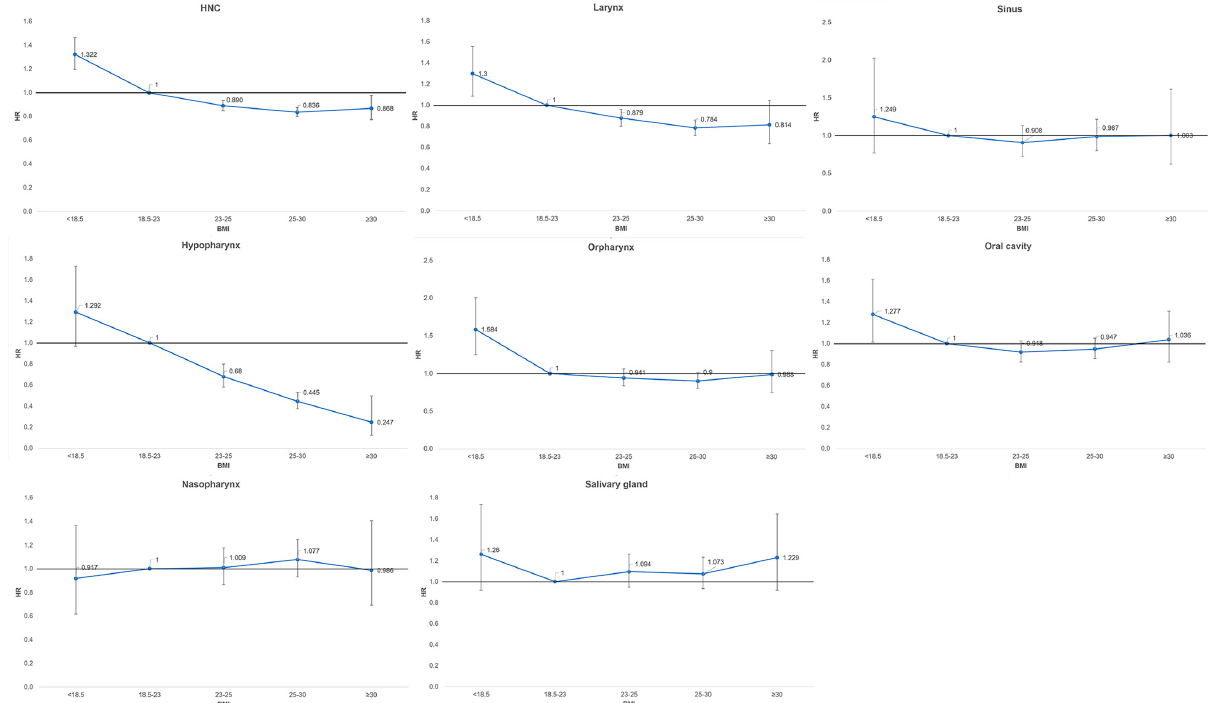
Figure 1. Hazard ratios (HR) of head and neck cancer (HNC) and its subtypes according to body mass index (BMI). All HRs were adjusted for age, sex, income, smoking, alcohol consumption, regular exercise, diabetes, and hypertension. Table 2. Hazard ratios of head and neck cancer and its subtypes according to body mass index level.